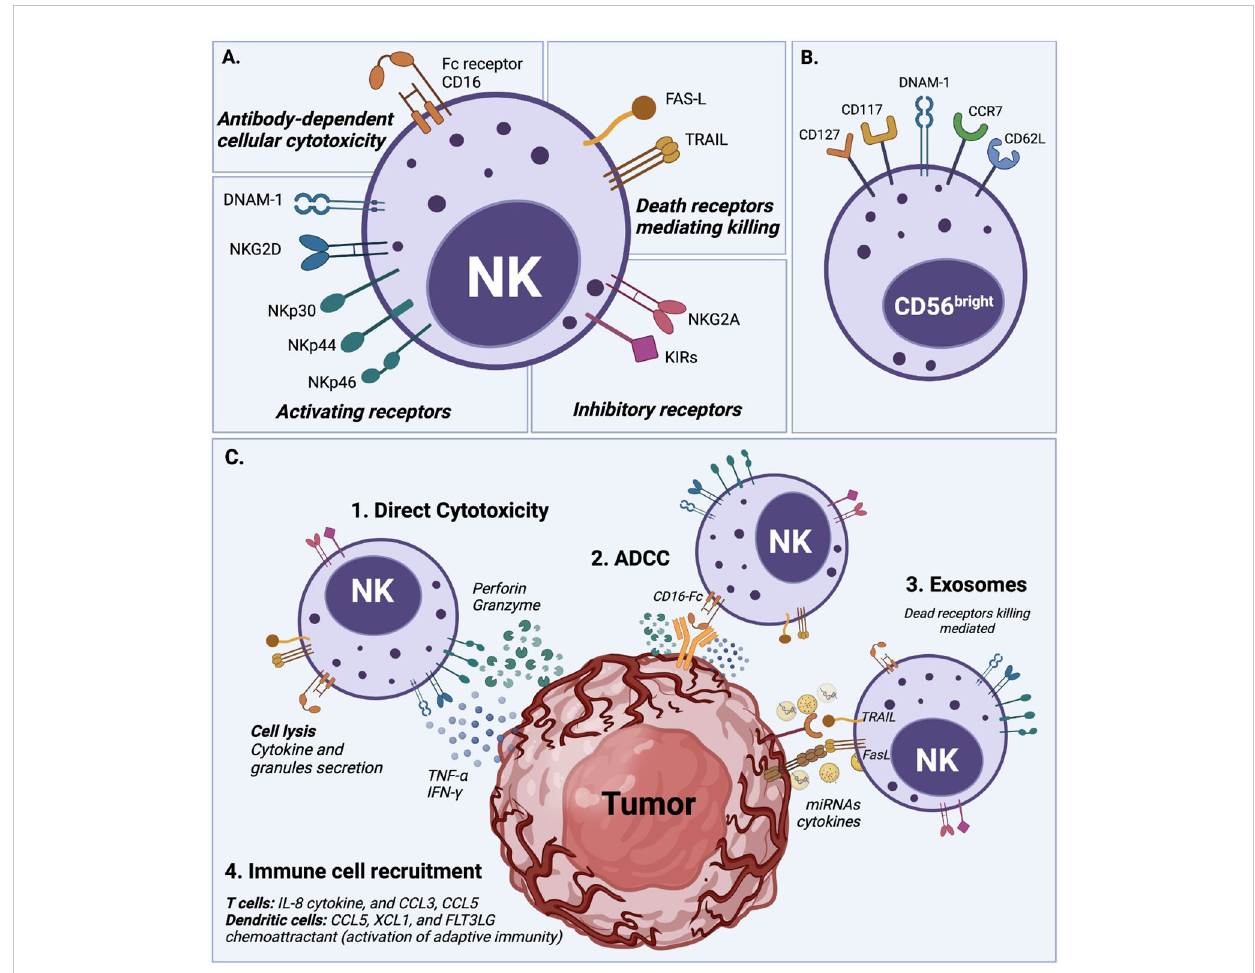
FIGURE 1 NK cell activation and natural cytotoxicity. (A) NK cells have a natural ability to recognize abnormal cells and exert cell cytotoxicity through different mechanisms. (1) NK cells exert direct cytotoxicity against compromised cells mainly by the secretion of IFN- g and TNF- a cytokines, and the release of perforin and granzyme cytolytic granules. (2) Antibody-dependent cellular cytotoxicity (ADCC) is another mechanism of NK cell cytotoxicity, which is mediated by the CD16 (FcRIII) receptor after recognizing and bound target cells. (3) NK cells display dead receptors, FAS-L and TRAIL, and exert their killing capability against compromised cells through the release of exosome that contains small non-coding RNAs (miRNAs) and cytokines (8 – 10). (4) The immune cell recruitment of T cells and dendritic cells also plays an essential role in NK cell cytotoxicity to enhance their action through soluble cytokine IL-2 and chemokine (CCL3, CCL5, XCL1, and FLT3LG) secretion. (B) Overview of NK cell receptors. All described cytotoxicity mechanisms are in response to an orchestrated balance of activating receptors (e.g., DNAM-1, NKG2D, NKp30, NKp44, NKp46) and inhibitory receptors (e.g., NKG2A, KIRs family) that determine the NK cell activation state. (C) Phenotype of circulating CD56 bright NK cells which typically express DNAM-1, CD62L (L-selectin), and CCR7, but also in some cases CD117 (c-kit), and CD127 (IL-7R a